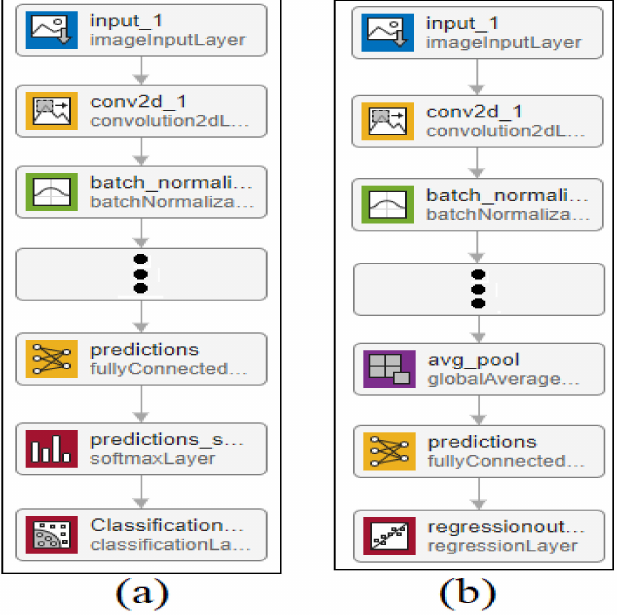
Figure 6. Proposed head pose CNN detector and eye gaze estimation using classification and the CNN regression